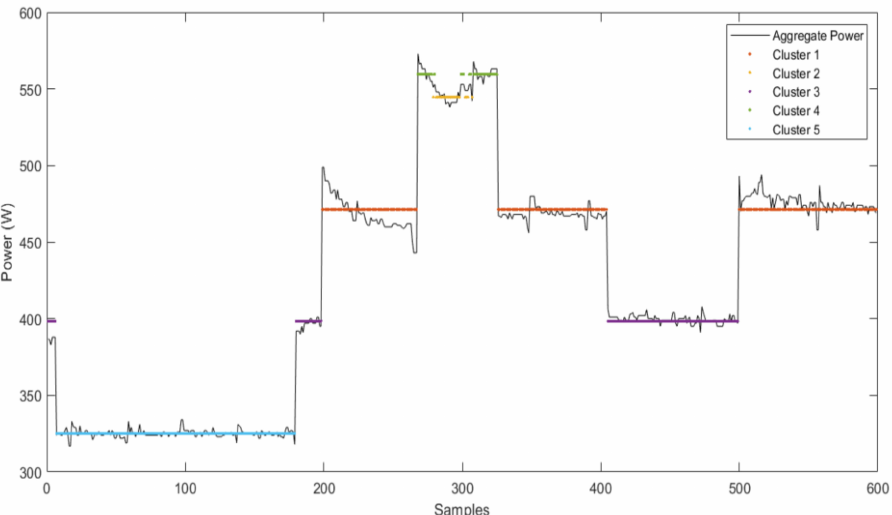
Figure 6. Example of REFIT data clustering using SC-M. According to the legend, different colors show separate cluster assignments of aggregate (black) and the mean of each cluster, which is further used for device/state identification.